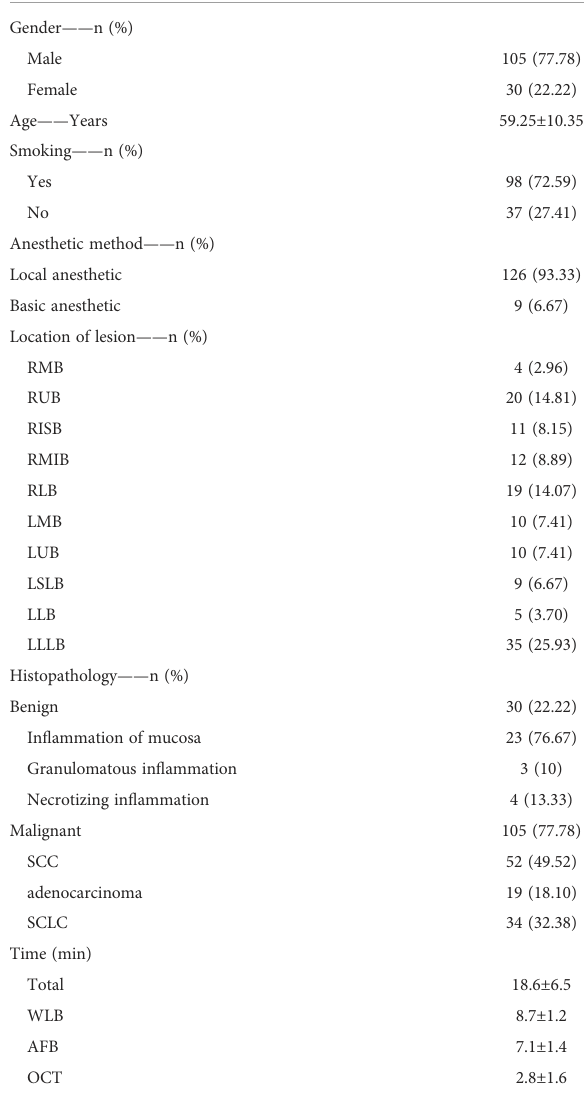
TABLE 1 The clinical data of